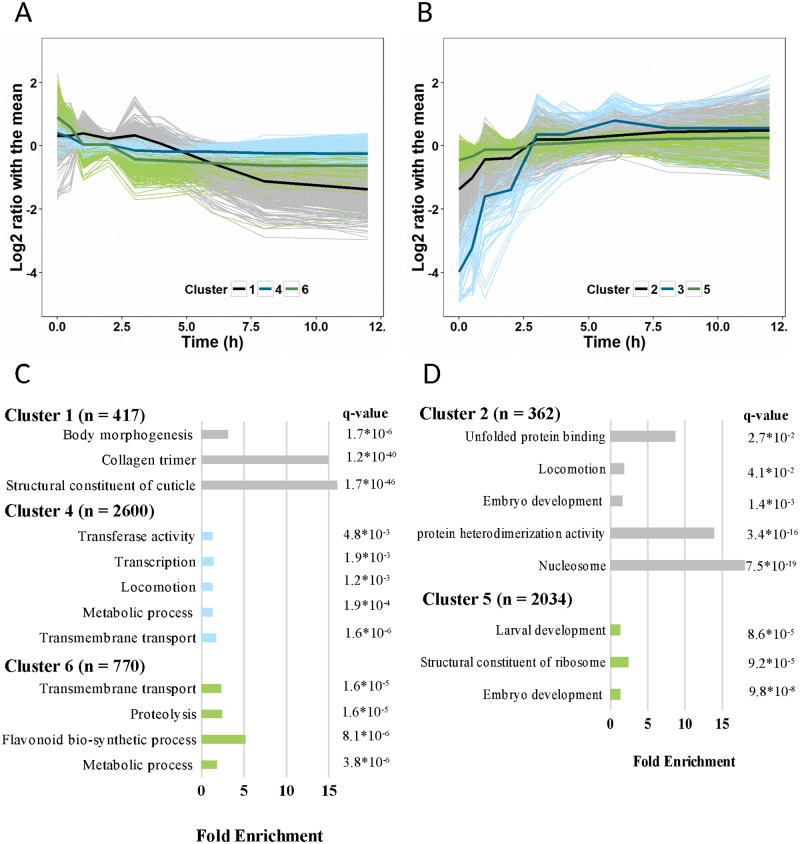
Temporal dynamics and functional enrichments of gene expression in response to continuous heat stress at 35°C.Genes with similar patterns in expression (log2 ratio with the mean) were grouped by k-means clustering. Dark coloured bold lines present the average expression of the individual clusters; lighter corresponding colours present the expression of individual genes. Enrichment analysis of gene clusters was performed with DAVID 6.8. (A) Cluster 1, 4, and 6 showed a downward trend in gene expression during heat stress. (B) Cluster 2, 3, and 5 were upregulated in response to heat stress. (C) Enrichment of downregulated gene clusters. (D) Enrichment of upregulated gene clusters 2 and 5. Analysis of cluster 3 did not result in a significant enrichment.